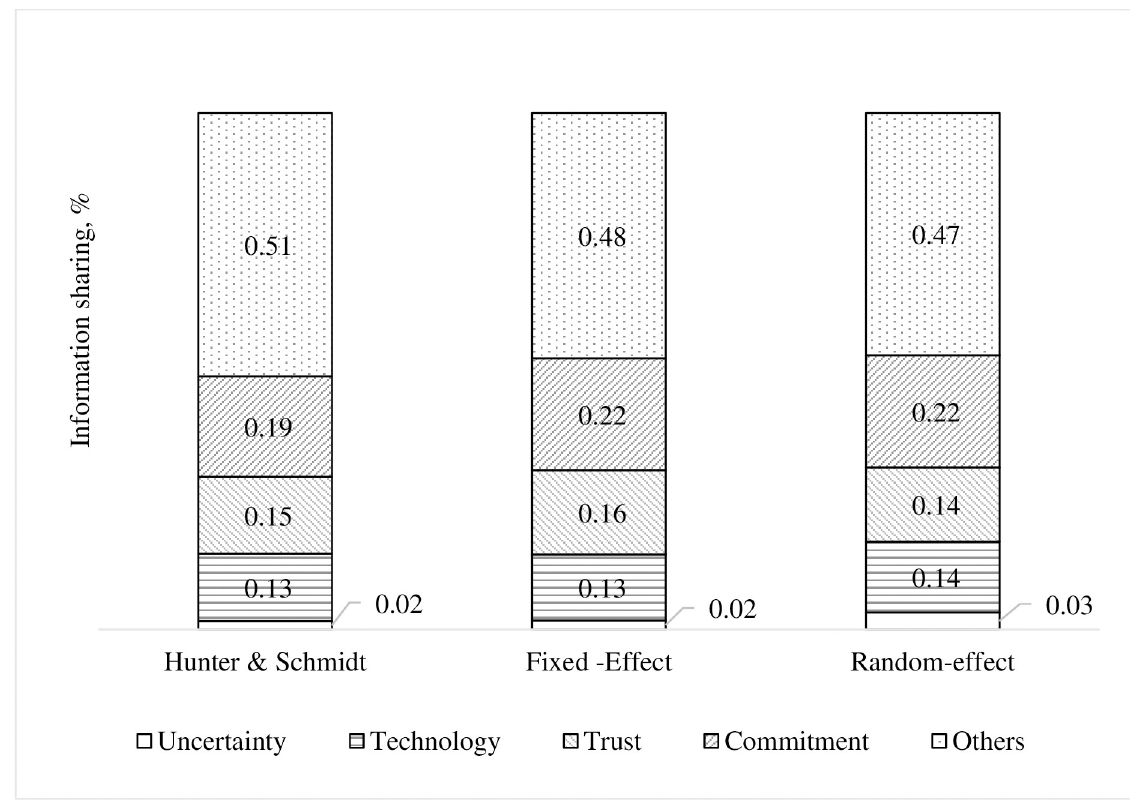
Fig 2. The effect of factors on information sharing variance.